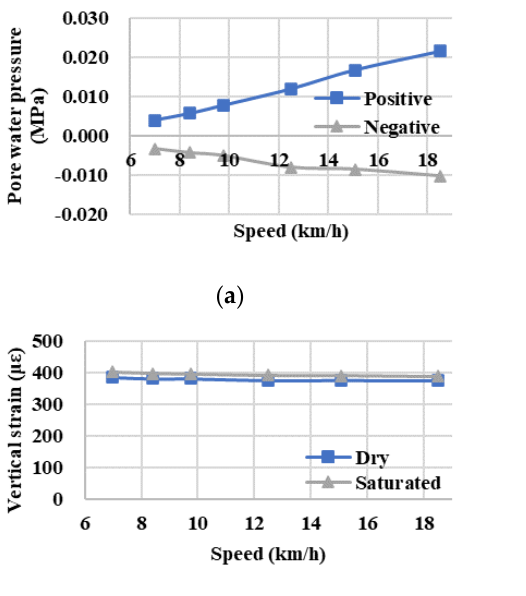
Figure 12. Variations of dynamic response magnitudes with vehicle load obtained from field tests (controlling vehicle speed at 20 km/h): ( a ) Pore water pressure; ( b ) Vertical stress; ( c ) Vertical strain; ( d ) Transverse strain.